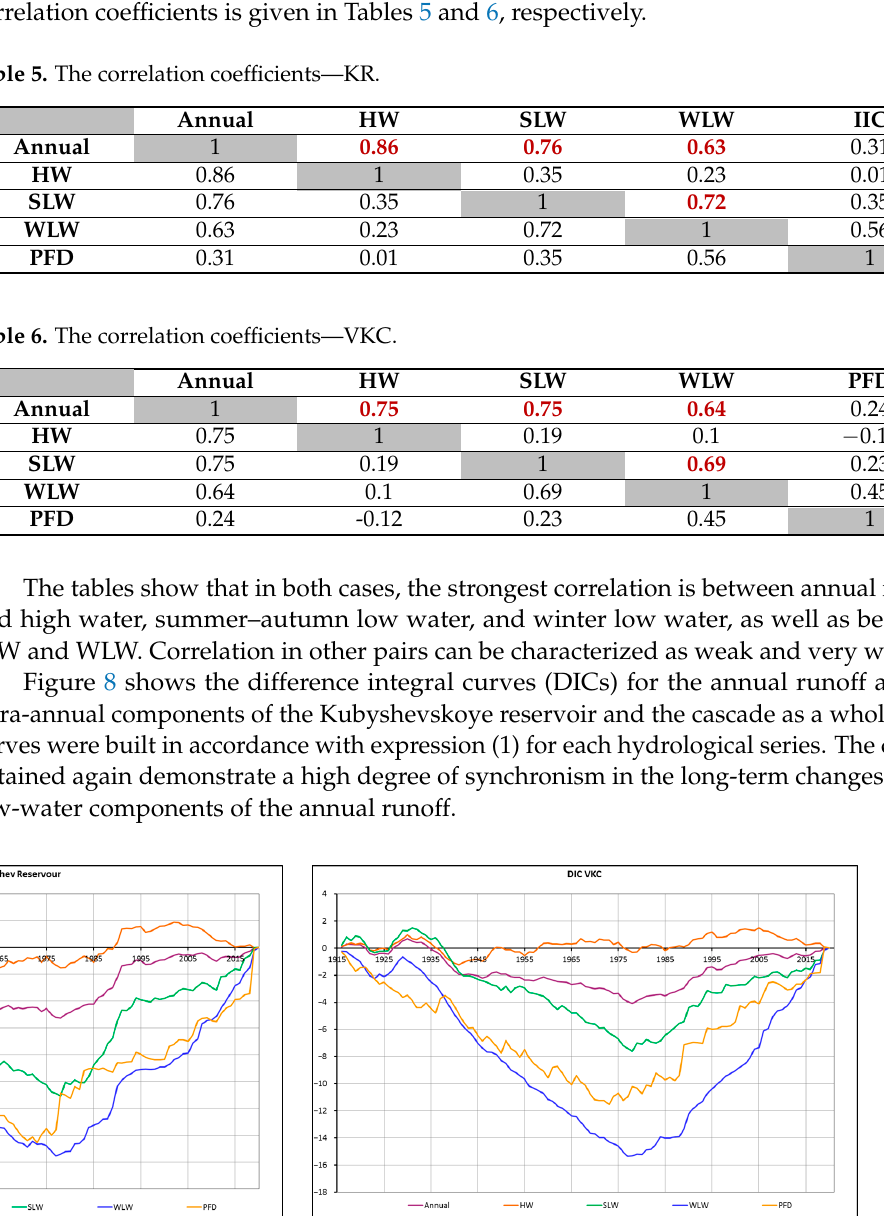
Figure 8. Di ff erence integral curves. Figure 8. Difference integral